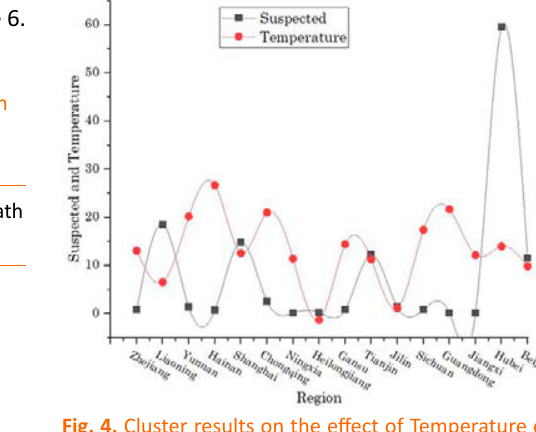
Fig. 4. Cluster results on the effect of Temperature on the suspected COVID-19